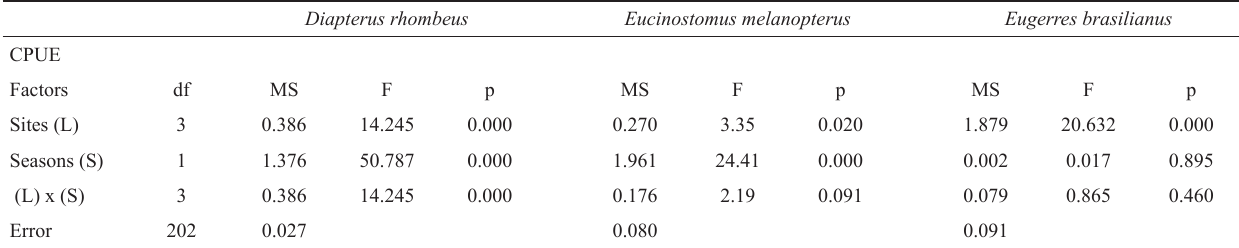
Fig. 3 . Spatial variation of numerical abundance of the three species ( Diapterus rhombeus , Eucinostomus melanopterus and Eugerres brasilianus ) in the rio Mamanguape estuary, Brazil. Table 4. F-values from two-way analysis of variance and comparisons (Tukey test) for numerical abundance (CPUE) for the three species between sites in the rio Mamanguape estuary, northeastern